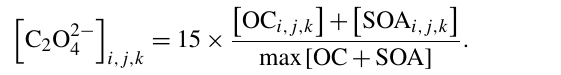
coefficient (Meskhidze et al., 2005), a( H + ) is the proton concentration with an empirical reaction order m i , f ( ∇ G r